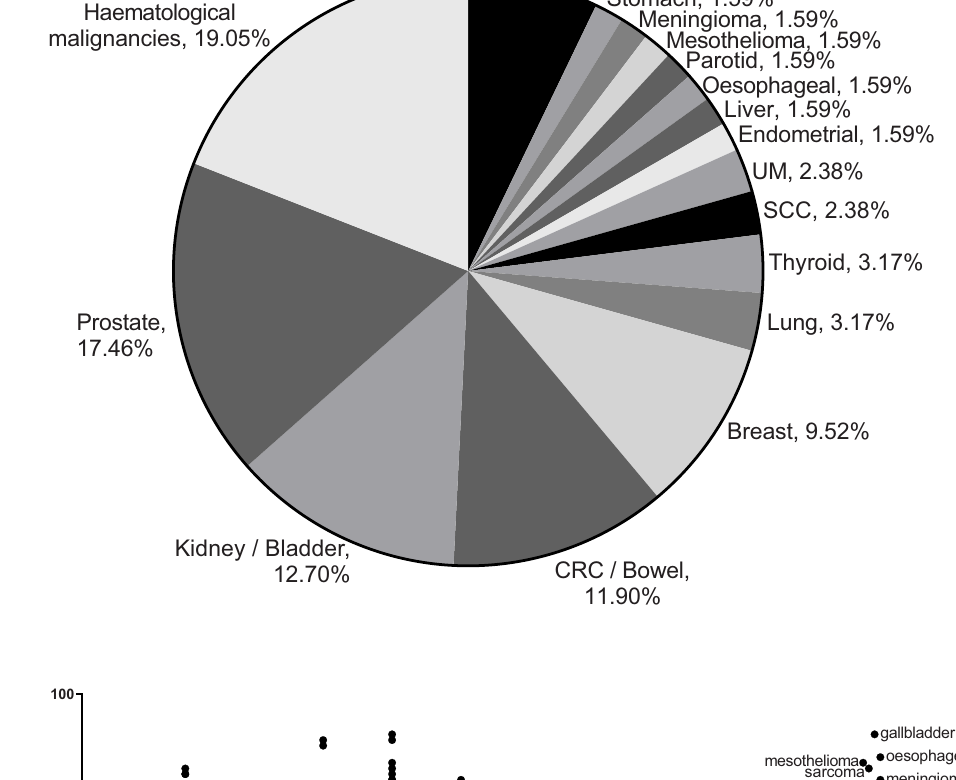
parotidparotidsarcoma meningioma merkel cell liver ovary liver